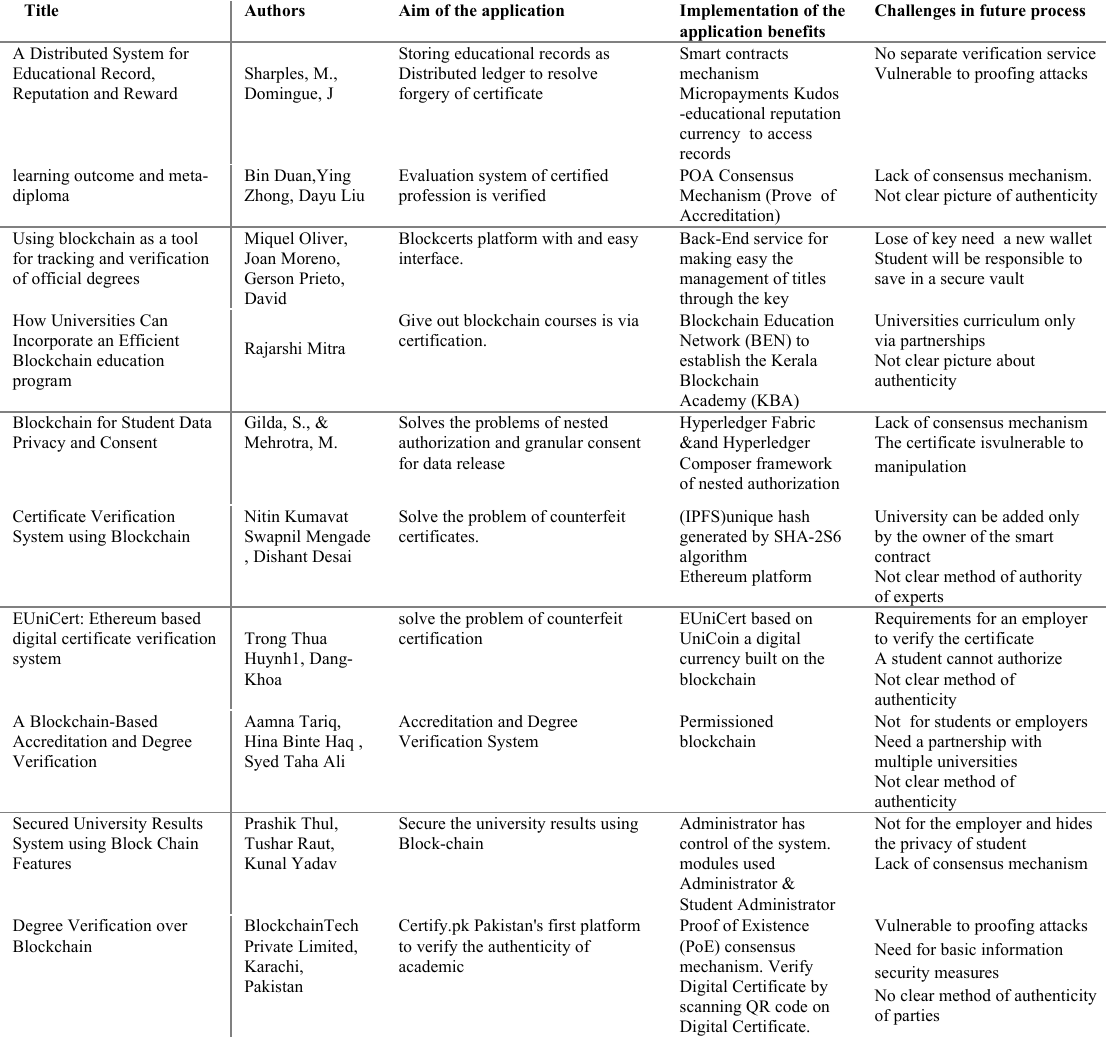
Table 2. Sum-up the comparison of various applications, implementation mechanism and